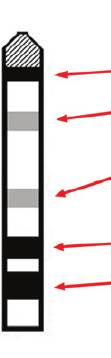
Fig. 5, a-c. Spreads from E. talpinus spermatocyte immunolabeled with antibodies to the SCP3 (green) and centromere (red; ACA) proteins at different stages of prophase I of meiosis. a - early zygotene. The formation of the axial elements without bouquet confi guration is visible. b - middle pachytene. Autosomal SCs are uniformly stained; and the SCP3 distribution in the asynaptic regions of the sex bivalent (XX) axes has the powder-like pattern. Short arms of some chromosomes are visible (arrow heads). Signals of the ACA on one SC lie on distance from each other (arrow). b' - Short acrocentric SC with two ACA signals, which lie on distance from each other. Bar = 0.5 μm. c - late pachytene. Banding pattern of the SCP3 protein distribution over autosomal SCs and a very weak SCP3 fl uorescence signal on the sex bivalent axial elements. Numbers of SCs correspond to numbers of metaphase chromosomes E. talpinus according to Romanenko et al. (2007). Bar = 3 μm.